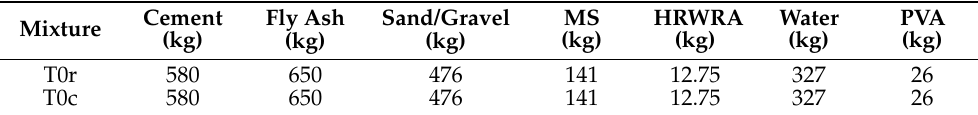
Table 1. Reference mix contents T0r and